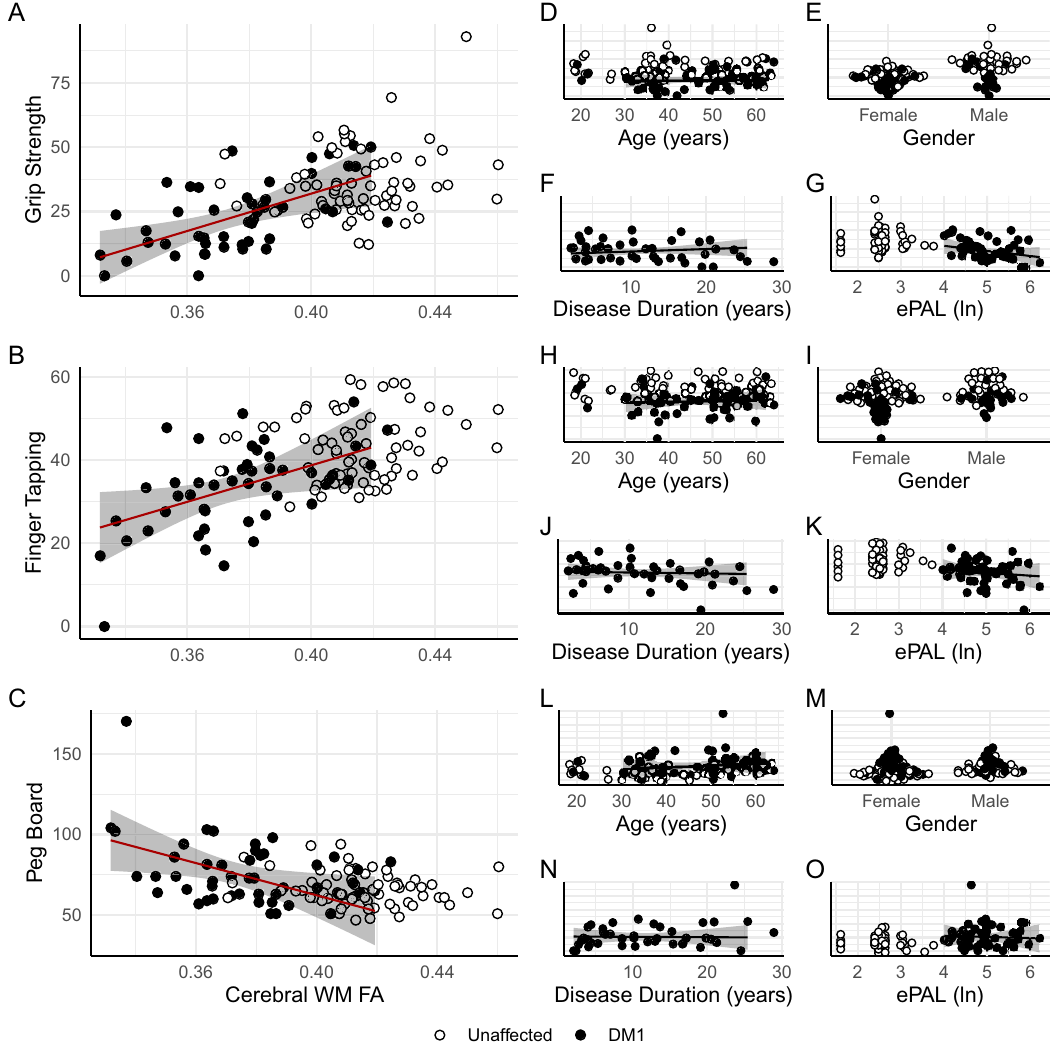
Figure 3. Cerebral white matter fractional anisotropy predicts motor outcomes. Cerebral WM FA predicts grip strength (panel A ), finger-tapping (panel B ), and peg board performance (panel C ) in DM1. Other variables included in statistical models including age, sex, disease duration, and genetic burden are not significantly related motor outcomes (panels D – O ). White circles indicate values for unaffected individuals for comparison, though are not included in statistical models. Lines represent fitted values from the respective models, red indicates significant effects, and the shaded regions represent estimates of the 95% confidence intervals. Data were plotted using R (version 3.5.0, https ://www.r-proje ct.org/) 25